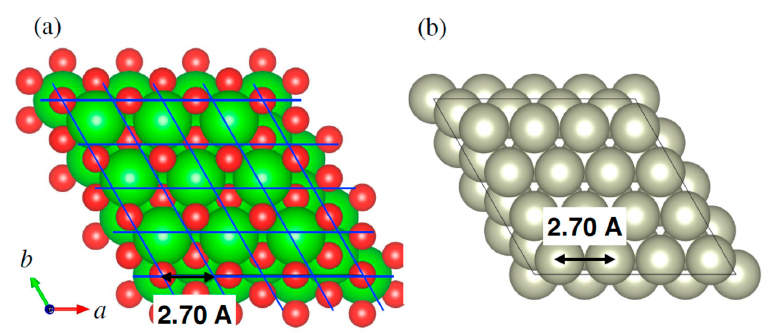
Figure 15. ( a ) Top view of a 3 × 3 O-terminated (111) surface of cubic ZrO 2 . The large green spheres represent Zr atoms and the small red spheres represent oxygen atoms. The blue lines represent a 4 × 4 mesh spaced 2.70 Å apart. ( b ) Top view of the three-layered Rh(111) 4 × 4 structure.